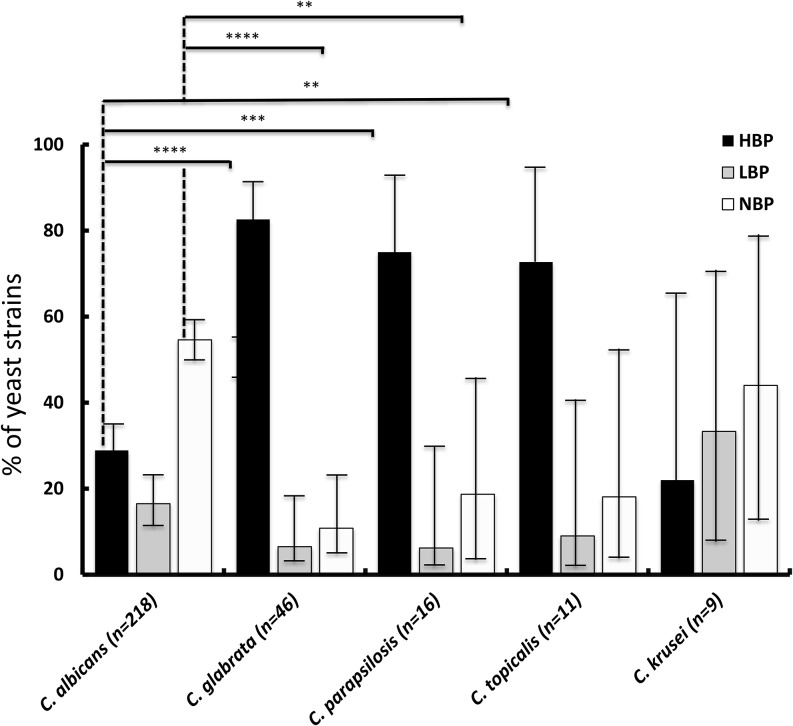
Biofilm production by the study strains of the main species, evaluated based on the biofilm ring test (HBP, high-biofilm producers; LBP, kow-biofilm producers; or NBP, no biofilm producers) [∗p < 0.008 (significance threshold after Bonferroni correction for multiple tests); ∗∗p < 0.000; ∗∗∗p < 0.0000; ∗∗∗∗p < 0.00000].